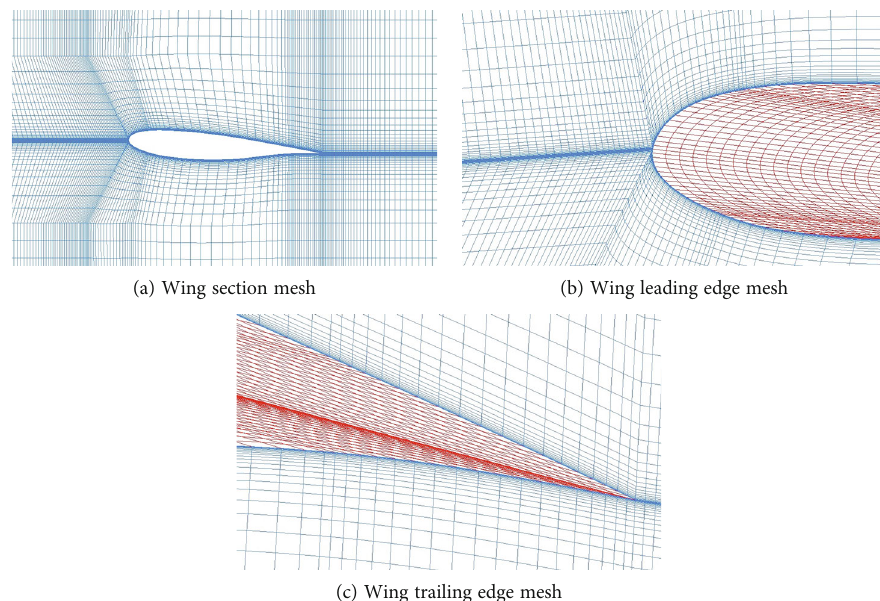
Figure 3: A330-200 wing computational mesh partial view.